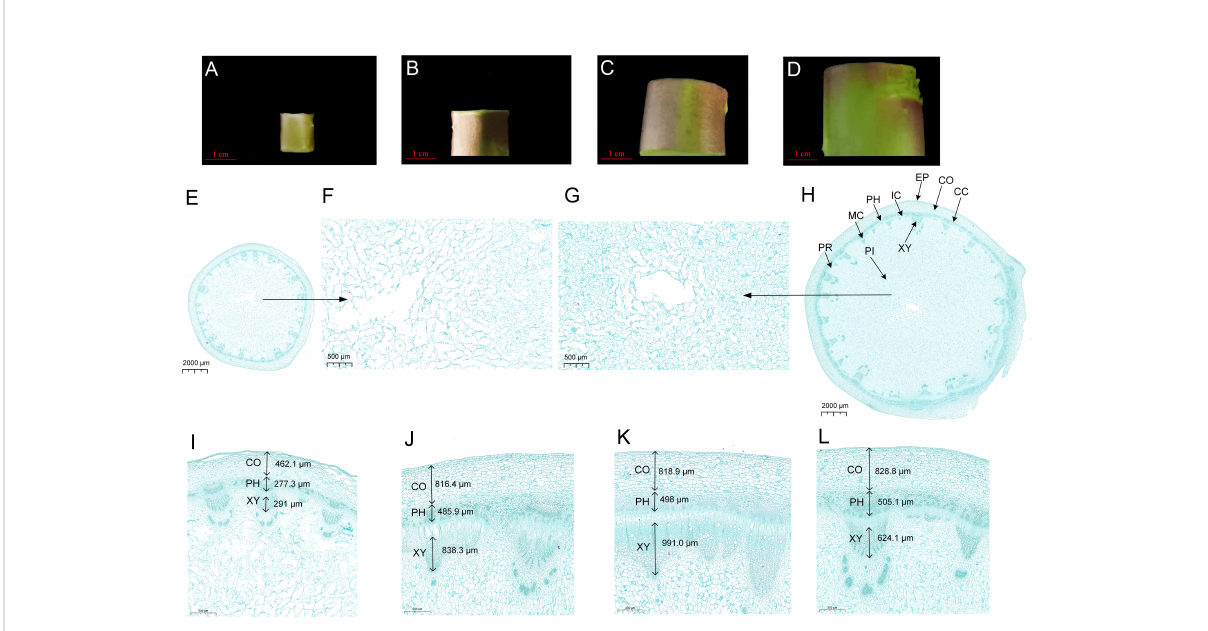
FIGURE 1 Anatomical analysis of lettuce fl eshy stem at different expansion stages (S1, S2, S3, and S4). (A – D) The transverse diameters are 1 cm (S1 stage), 2 cm (S2 stage), 3 cm (S3 stage), and 4 cm (S4 stage), respectively, (E) Global cross-sections of S1 stage, (F) Local maps of medullary cells at S1 stage, (G) Local maps of medullary cells at S4 stage, (H) Global cross-sections at S4 stage, (I – L) Local maps of the epidermis to vascular bundles from S1 to S4 stages. EP, Epidermis; CO, Cortex; CC, Cork Cambium; PH, Phloem; PR, Pith Ray; IC, Interfascicular Cambium; MC, Midbundle Cambium; XY, Xylem; PI,